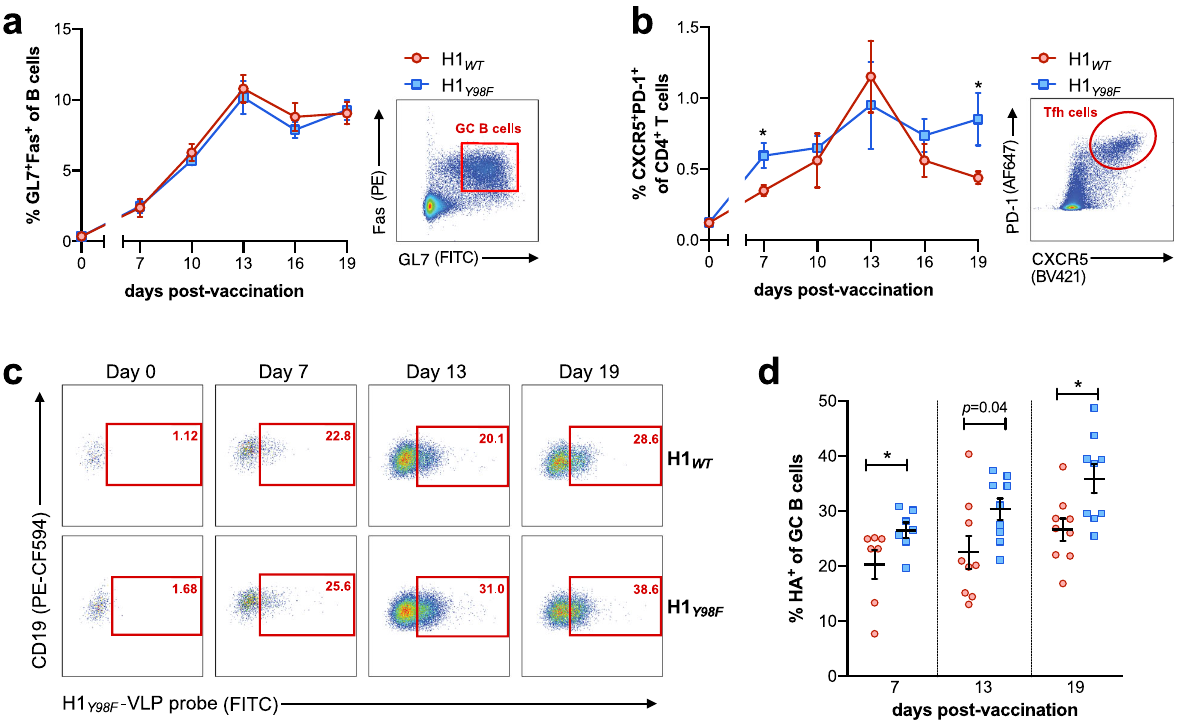
Fig. 3 H1 Y98F -VLP promotes enhanced germinal center selection. Mice were immunized with 0.5 µg H1 WT - or H1 Y98F -VLP in the right hind limb footpad and popliteal lymph nodes (pLN) were harvested at indicated time points. The mean frequency (±SEM) of ( a ) CD19 + Fas + GL7 + GC B cells and ( b ) CD3 + CD4 + CXCR5 + PD-1 + T FH cells was determined by fl ow cytometry. Representative plots showing GC B cell and T FH gating are shown on the right. To identify H1-speci fi c GC B cells, freshly isolated cells were incubated with 1 µg/ml H1 Y98F -VLP (30 min, 4 °C) and cognate GC B cells were detected following staining with anti-H1 FITC. c Representative plots and d mean frequency (±SEM) of HA + cells among GC B cells. Data are pooled from three independent experiments, n = 7 – 13/group at each time point. Statistical signi fi cance between groups at each time point was determined by Mann – Whitney test (* p <